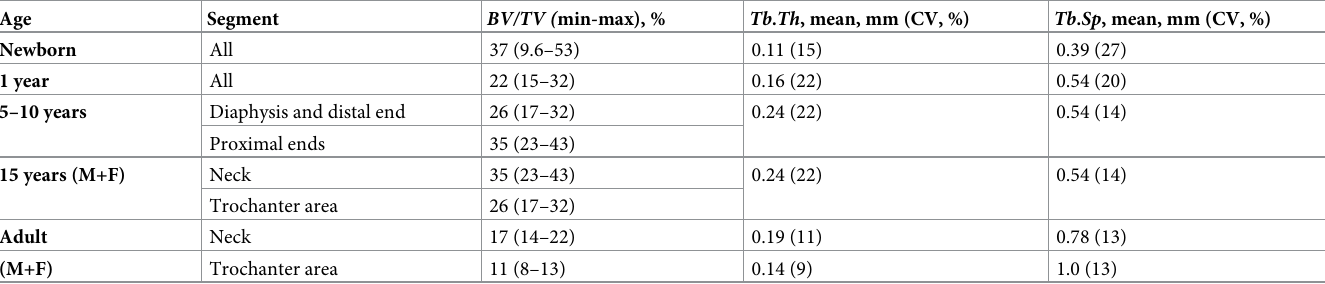
Table 6. Femur trabecular micro-structure parameters and their individual variability estimated for different